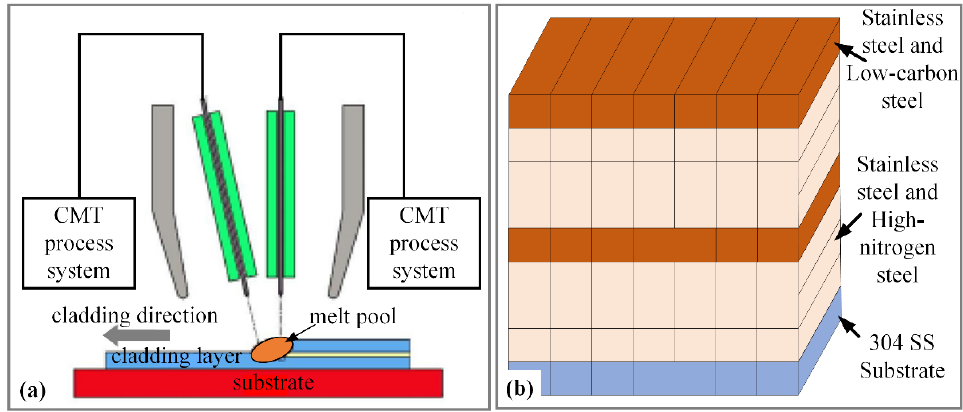
Figure 22. ( a ) Schematic of WAAM based on CMT with heterogeneous wires, ( b ) Schematic of FGMs [90].